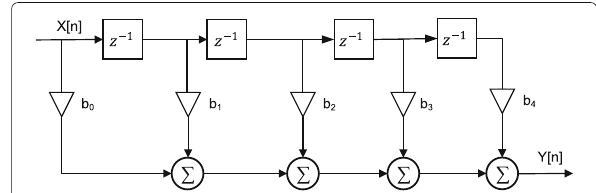
Fig. 1 Five-tap finite impulse response filter